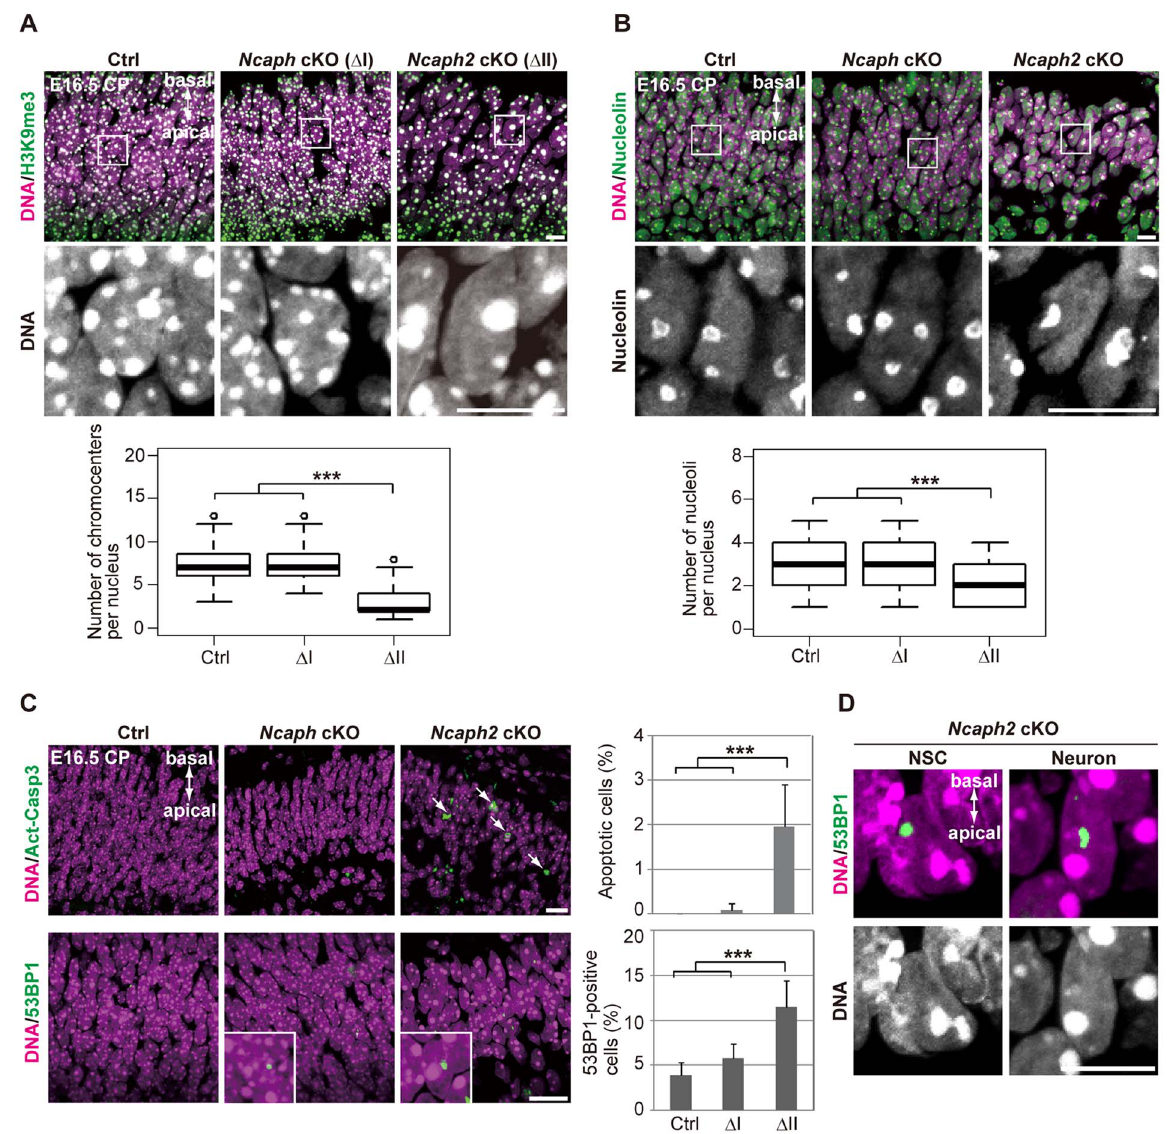
Figure 6. Depletion of condensin II affects nuclear architecture and cell survival in postmitotic neurons. ( A ) Frozen sections of embryonic brains at E16.5 were immunolabeled with an antibody against histone H3 trimethylated at lysine 9 (H3K9me3) along with Hoechst staining. Wide areas containing the CPs and close-up views of the nuclei indicated by the white rectangles are shown. The data shown are from a single representative experiment out of three repeats. Sections from three different embryos of each genotype were analyzed. Maximum intensity projections are shown. Bars, 10 m m. The numbers of chromocenters per nucleus in the CP were measured and plotted. Data were obtained from 100 nuclei in the CP. *** P , 0.001 ( t -test with a Holm correction for multiple comparisons). ( B ) The same sections were immunolabeled with an antibody against nucleolin along with Hoechst staining. Wide areas containing the CPs and close-up views of the nuclei indicated by the white rectangles are shown. The data shown are from a single representative experiment out of three repeats. Sections from three different embryos of each genotype were analyzed. Maximum intensity projections are shown. Bars, 10 m m. The numbers of nucleoli per nucleus in the CP were measured and plotted. Data were obtained from 50 nuclei and analyzed as in ( A ). ( C ) Frozen sections of embryonic brains at E16.5 were immunolabeled with antibodies against Act-Casp3 and 53BP1 along with Hoechst staining. The data shown are from a single representative experiment out of three repeats. Sections from three different embryos of each genotype were analyzed. Bars, 20 m m. The numbers of apoptotic and 53BP1-positive cells were measured and plotted. Data were obtained from four independent sections from two different embryos. The bars indicate the mean and SD. *** P , 0.001 ( t -test with a Holm correction for multiple comparisons). ( D ) The same sections were immunolabeled with an antibody against 53BP1 along with Hoechst staining. The data shown are from a single representative experiment out of three repeats. Sections from three different embryos of each genotype were analyzed. Maximum intensity projections are shown. Bar, 10 m m.